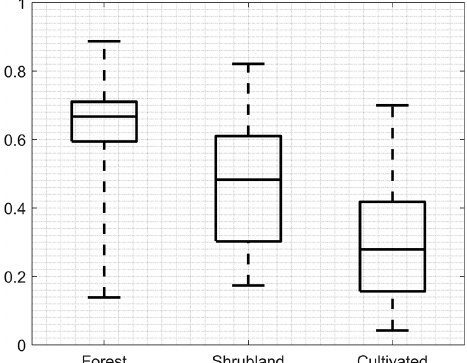
Figure 8. As in Fig. 6 but for the distribution of static probability of exceedance of the threshold of 2000GJ.